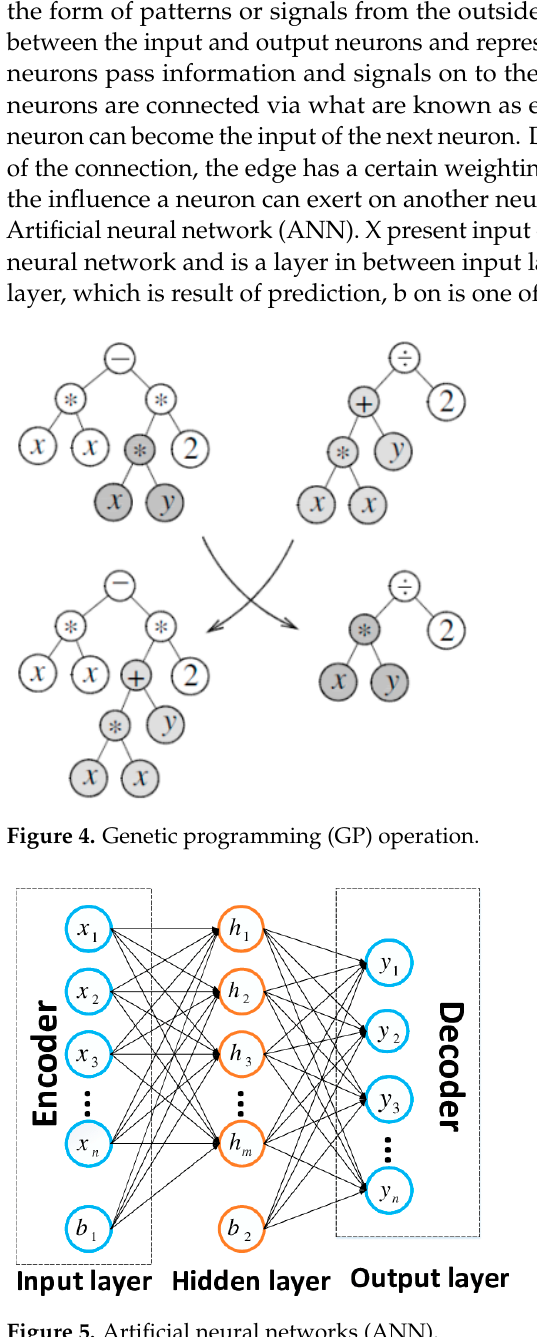
Figure 5. Artificial neural networks (ANN).